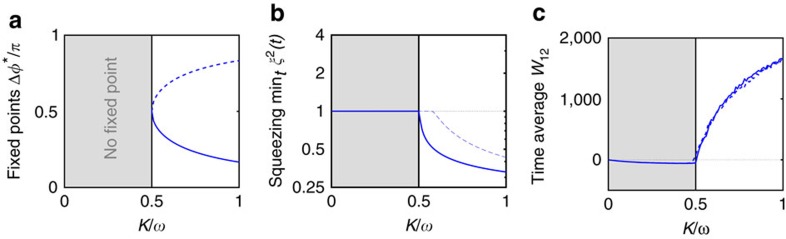
Classical synchronization indicates quantum squeezing and number entanglement.We consider two coupled oscillators, respectively, two quantum modes with variable coupling strength K. (a) The fixed points of the Kuramoto model (4). A stable (solid) and an unstable (dashed) fixed point emerge in a saddle node bifurcation at Kc=|ω|/2. (b) The temporal minimum of the squeezing parameter  (refs 13, 19) as a function of the coupling strength K. For U=0 (solid line) the transition to quantum squeezing is located at the critical coupling for classical synchronization, Kc=ω/2. The on-site interaction term ∼U suppresses squeezing such that the transition occurs at a higher value of K for U=0.4/N (dashed line). (c) Long-time average of the entanglement parameter W12 as a function of the coupling strength K. Persistent entanglement W12>0 (see ref. 50 and Methods) emerges with classical synchronization at K>Kc=ω/2, independent of U. The initial quantum state is a two-mode coherent state |z, Δφ〉=|0, π/2〉 with N=100 and ω=1 in all cases.